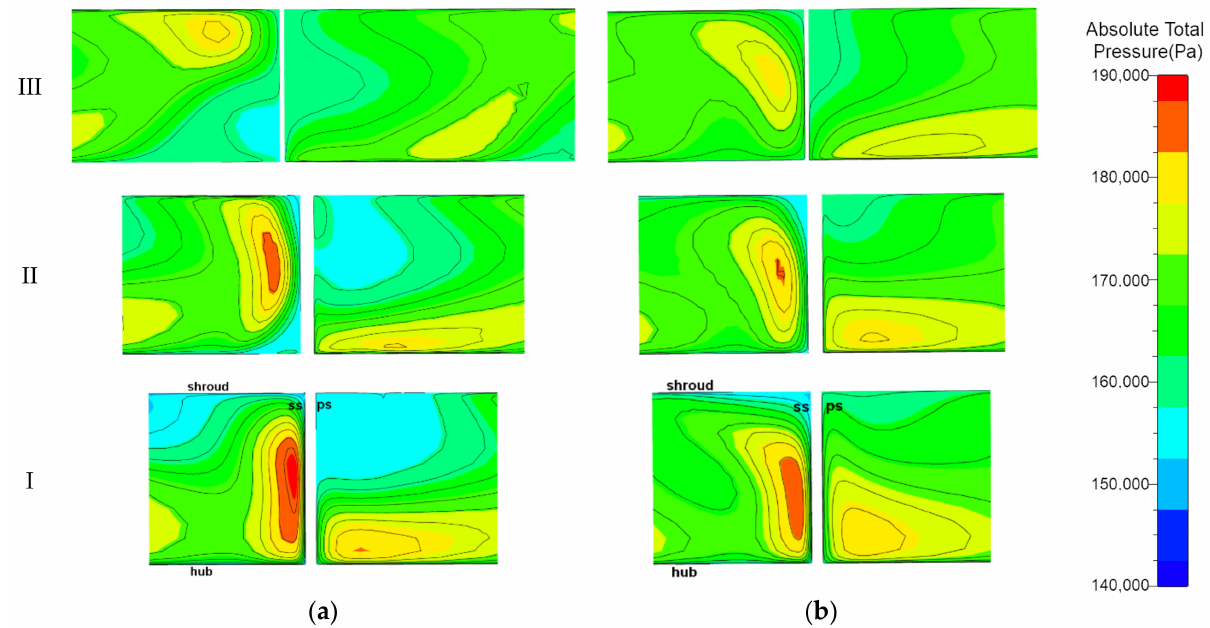
Figure 19. Total pressure distribution at radius cross section along the flow direction. ( a ) 0 ◦ model and ( b ) 10 ◦